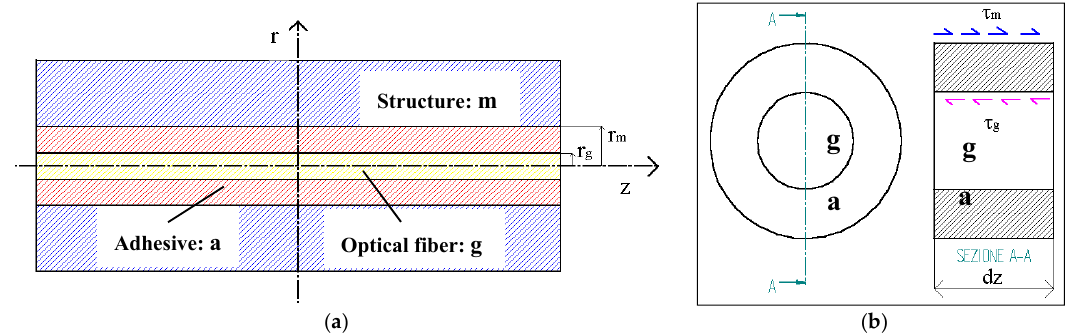
Figure 2. ( a ) Longitudinal section of the optical fibre; ( b ) transversal section.